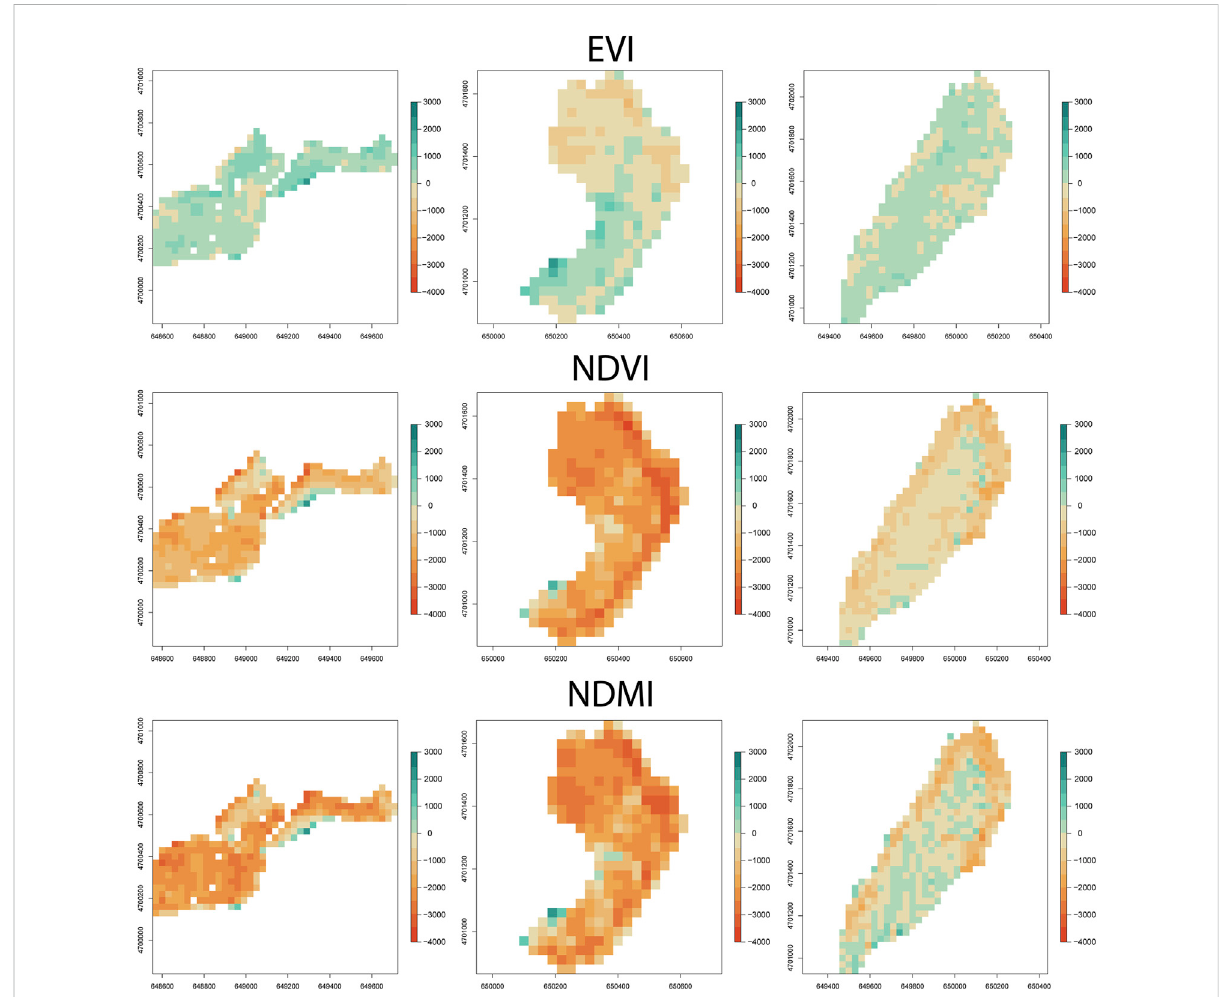
FIGURE 5 Vegetation recovery analysis for the enhanced vegetation index (EVI), normalized difference vegetation index (NDVI), normalized difference moisture index (NDMI), soil-adjusted vegetation index (SAVI), and modi fi ed soil-adjusted vegetation index (MSAVI) calculated by the difference between the index values pre and post the thinning